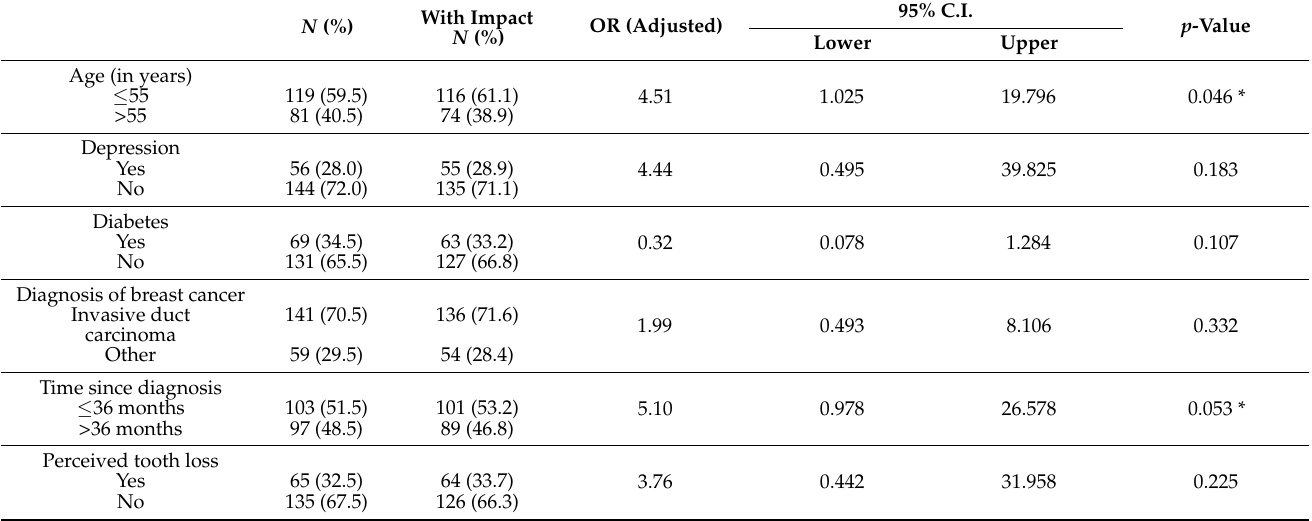
Table 4. Binary logistic regression analysis between the prevalence of impact and independent